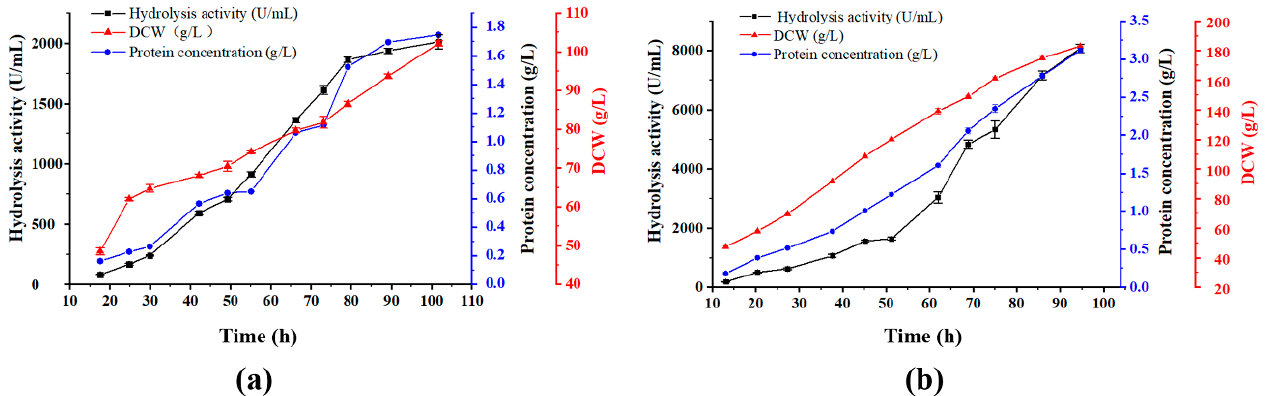
Figure 2. Time course of lipase hydrolysis activity ( ■ filled square), biomass (SCP) dry cell weight (DCW) ( ▲ fi lled triangle), and total protein concentration ( ● fi lled circle) of the best engineered Y. lipolytica strain during fed-batch fermentation in a 10 L fermenter with 4 L initial modified FM22 medium. ( a ) Raw glycerol and sucrose were used as co-feeding carbon sources; ( b ) raw glycerol was used as the sole carbon